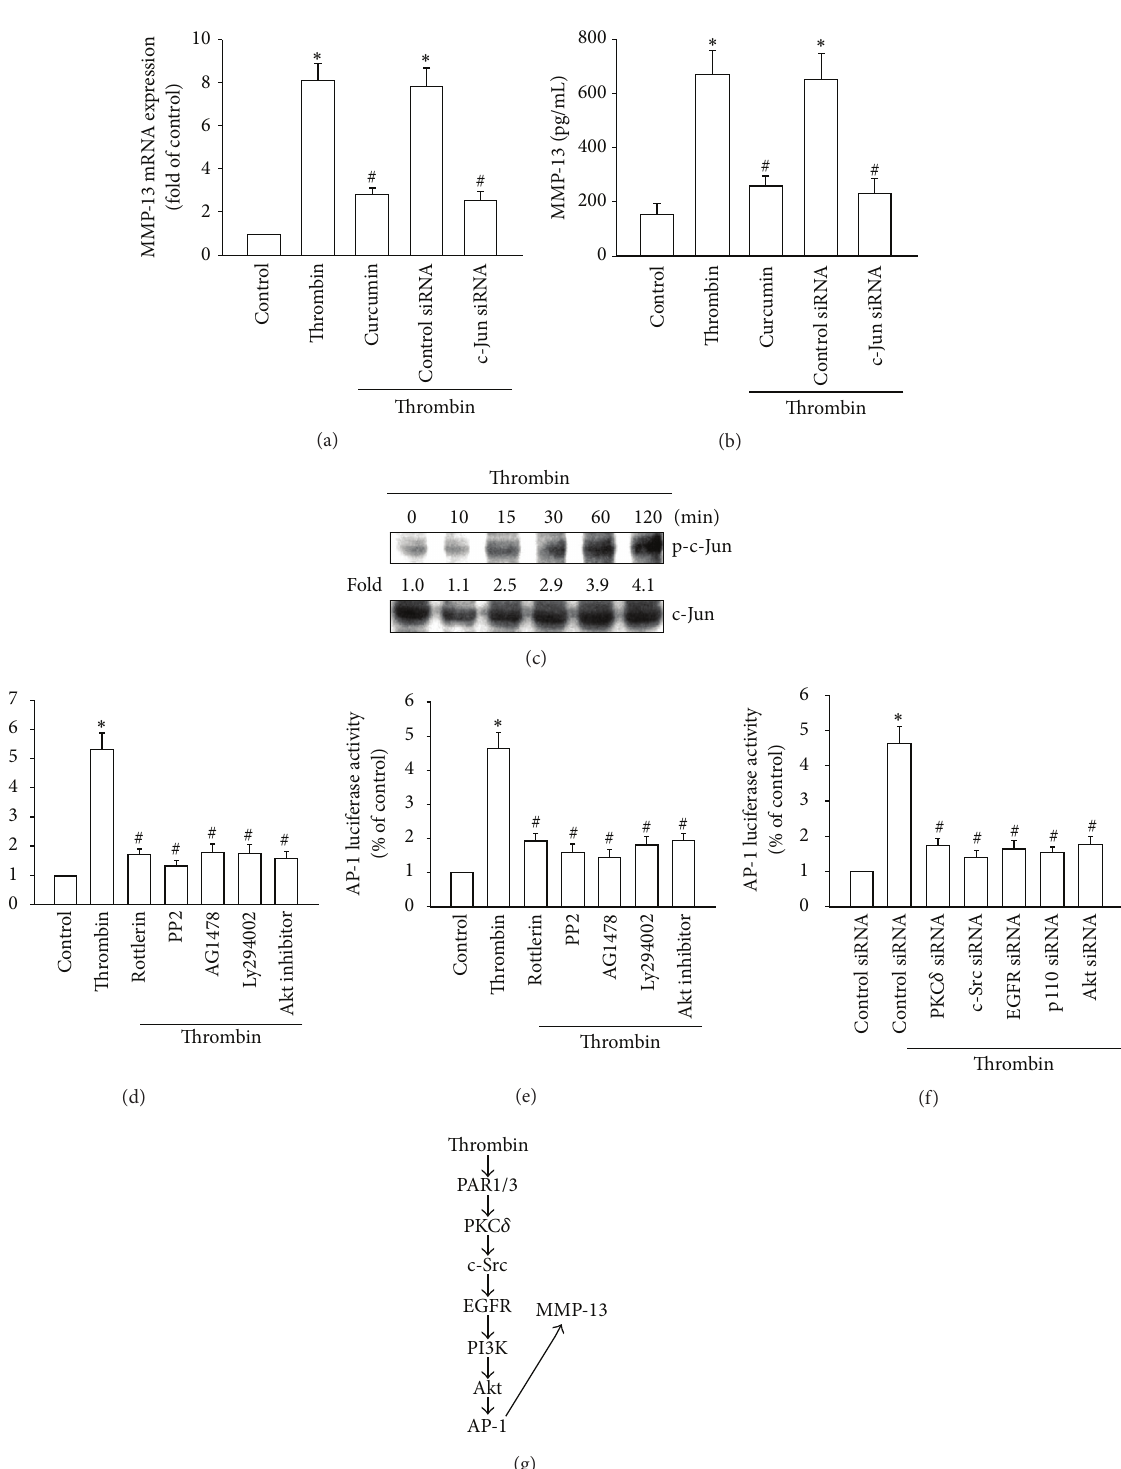
Figure 6: Involvement of AP-1 in the thrombin-induced enhancement of MMP-13 production. ((a) and (b)) qPCR and ELISA analyses of MMP-13 expression in chondrocytes, which were pretreated with curcumin for 30 min or transfected with c-Jun siRNA for 24 h and then stimulated with thrombin for 24 h. ((c) and (d)) Western blotting analyses of c-Jun phosphorylation in cells incubated with thrombin for the indicated time intervals and in cells pretreated with rottlerin, PP2, AG1478, Ly294002, or the Akt inhibitor for 30 min and stimulated with thrombin. ((e) and (f)) Chromatin immunoprecipitation and luciferase activity assays of AP-1 (f). Luciferase activity assays of cells transfected withsiRNAsagainst PAR1,PAR3, PKC 𝛿 ,c-Src,EGFR, p110,orAkt for24handthenstimulatedwiththrombinfor24h. ∗ 𝑃 < 0.05 ascompared with basal levels. # 𝑃 < 0.05 as compared with the levels in the thrombin-treated group. (g) Schematic representation of the signaling pathways involved in thrombin-induced MMP-13 expression in human